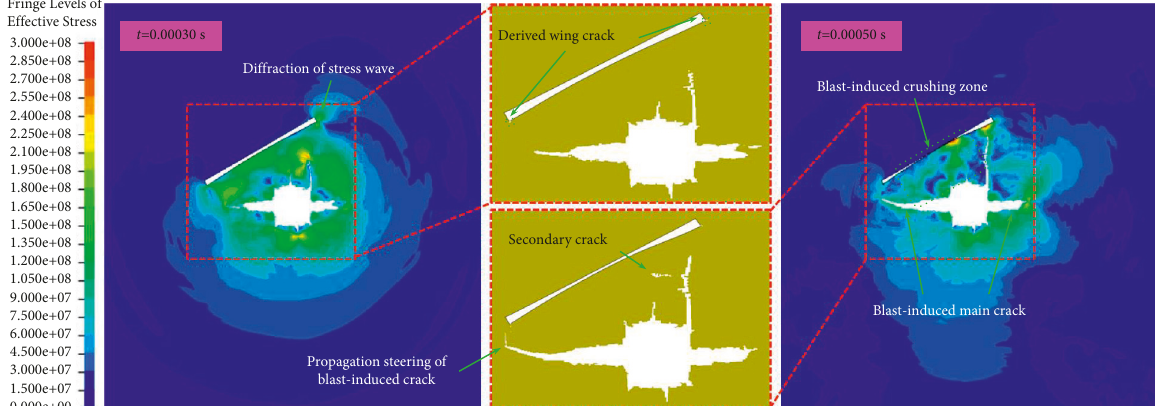
Figure 5: Pressure diagram of explosion stress wave transmission for case CN